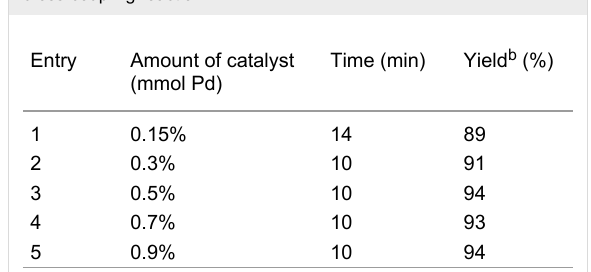
Table 3: Effect of the amount of Cell–OPPh 2 –Pd 0 catalyst on the cross-coupling reaction a